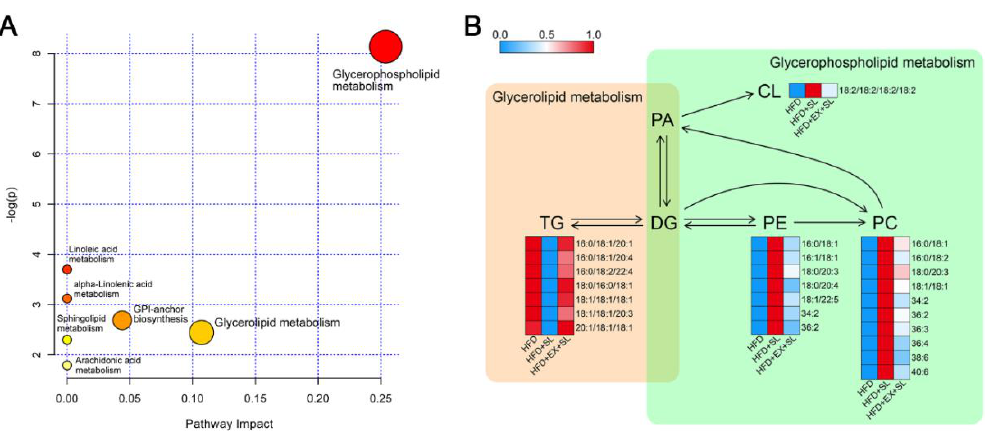
Figure 7. Lipid metabolic pathway analysis of differential lipid species. ( A ) Bubble chart of the pathway analysis by MetaboAnalyst. ( B ) Summary of the main relationships among differential lipid species related to glycerophospholipid and glycerolipid metabolism. Red denotes a relative increase, and blue denotes a relative decrease.